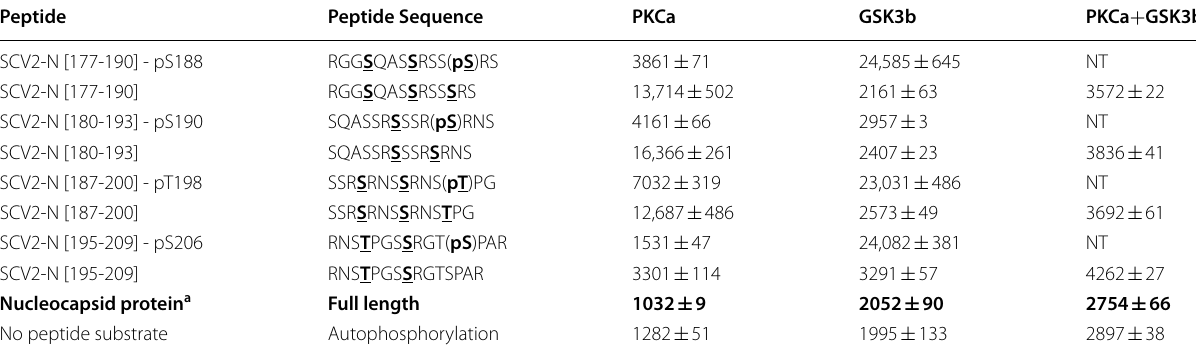
Predicted GSK3 phosphorylation sites are bolded and underlined. Results are presented as Mean NT not tested a Relative phosphorylation is shown in comparison to the signal with the nucleocapsid protein incubated in the absence of added substrate with ATP alone (set to